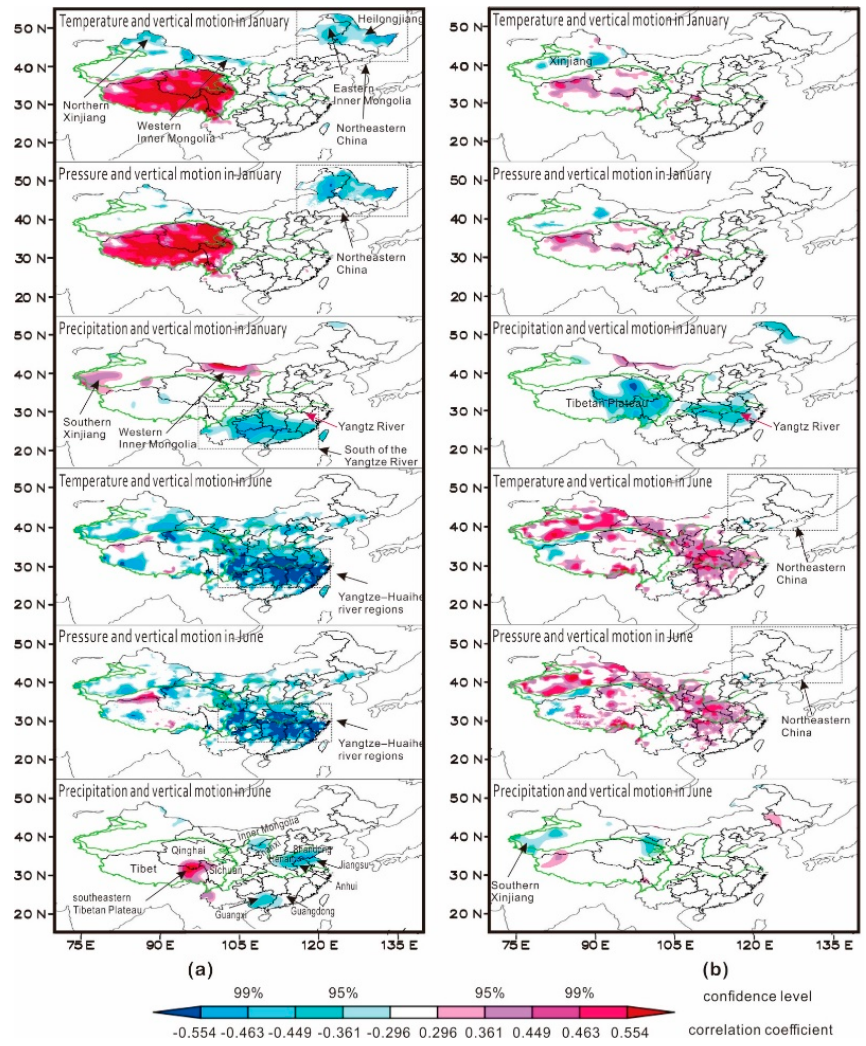
Figure 4. Correlation analysis between the surface meteorological variables and the vertical motion of air for ( a ) the Tibetan Plateau and ( b ) the North Pacific. Red shades denote a positive correlation and blue shades denote a negative correlation. Note: the South China Sea has not been marked due to layout reasons.